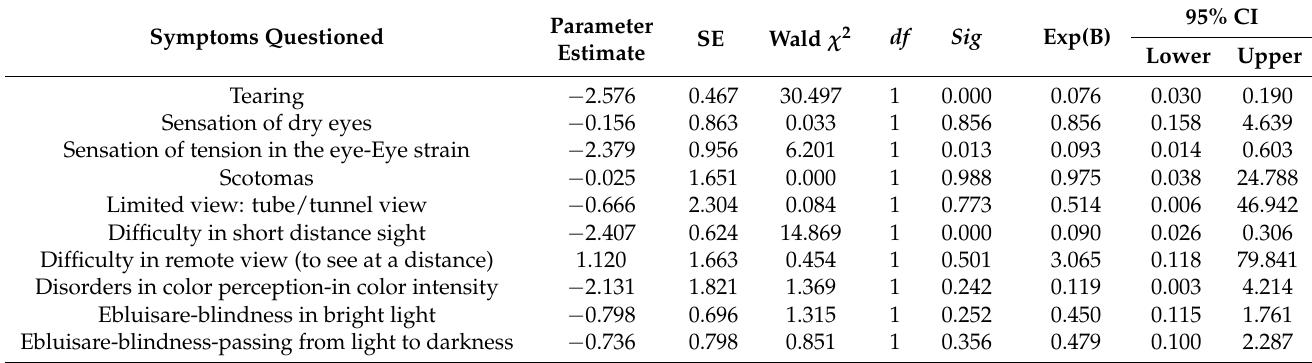
Table 10. Distribution of binomial logistic regression parameters to the symptom